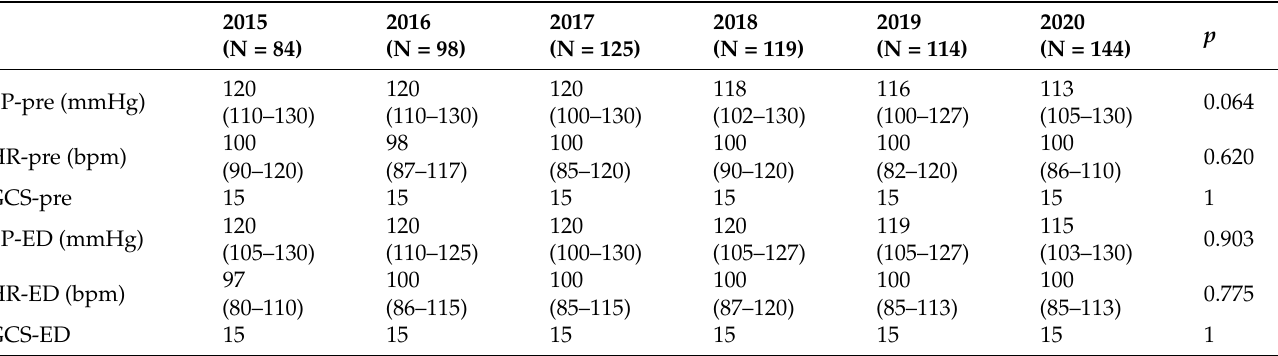
Table 2. Clinical presentation: pre-hospital and ED vital signs.